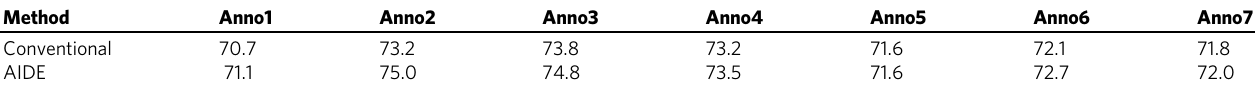
Table 4 Segmentation performance (DSC: %) of Task2_Brain Growth Segmentation on the QUBIQ